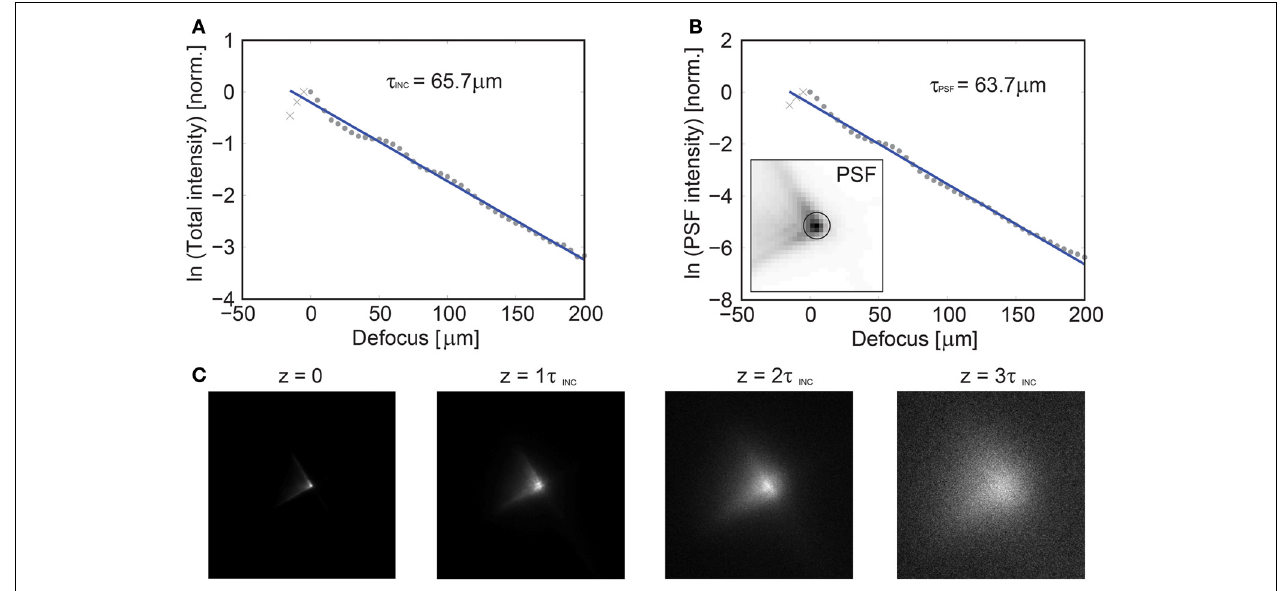
= 65 . 7 μ m. In an attempt to quantify the loss of the PSF fidelity with τ INC increasing scattering, a circular region was defined [centered on the peak intensity, insert (B) ] and the relative loss of energy was plotted as a function of depth, yielding τ PSF = 63 . 7 μ m (B) . An image of the PSF is given as a function of τ INC in (C) and the PSF fidelity is observed to degenerate by ∼ 3 τ INC , at which point the system performance approaches that of a conventional SLM